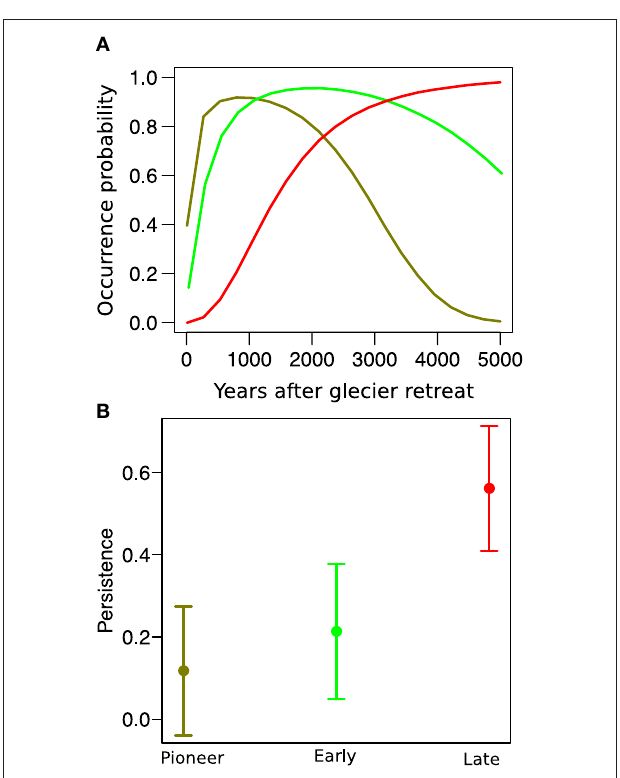
FIGURE 3 | (A) Distribution of three “model” species along the glacier foreland: the pioneer Artemisia genipi (dark green), the early Luzula alpino-pilosa (light green), and the late Carex curvula (red). (B) Persistence probability of species after glacier extinction across pioneer, early, and late species.